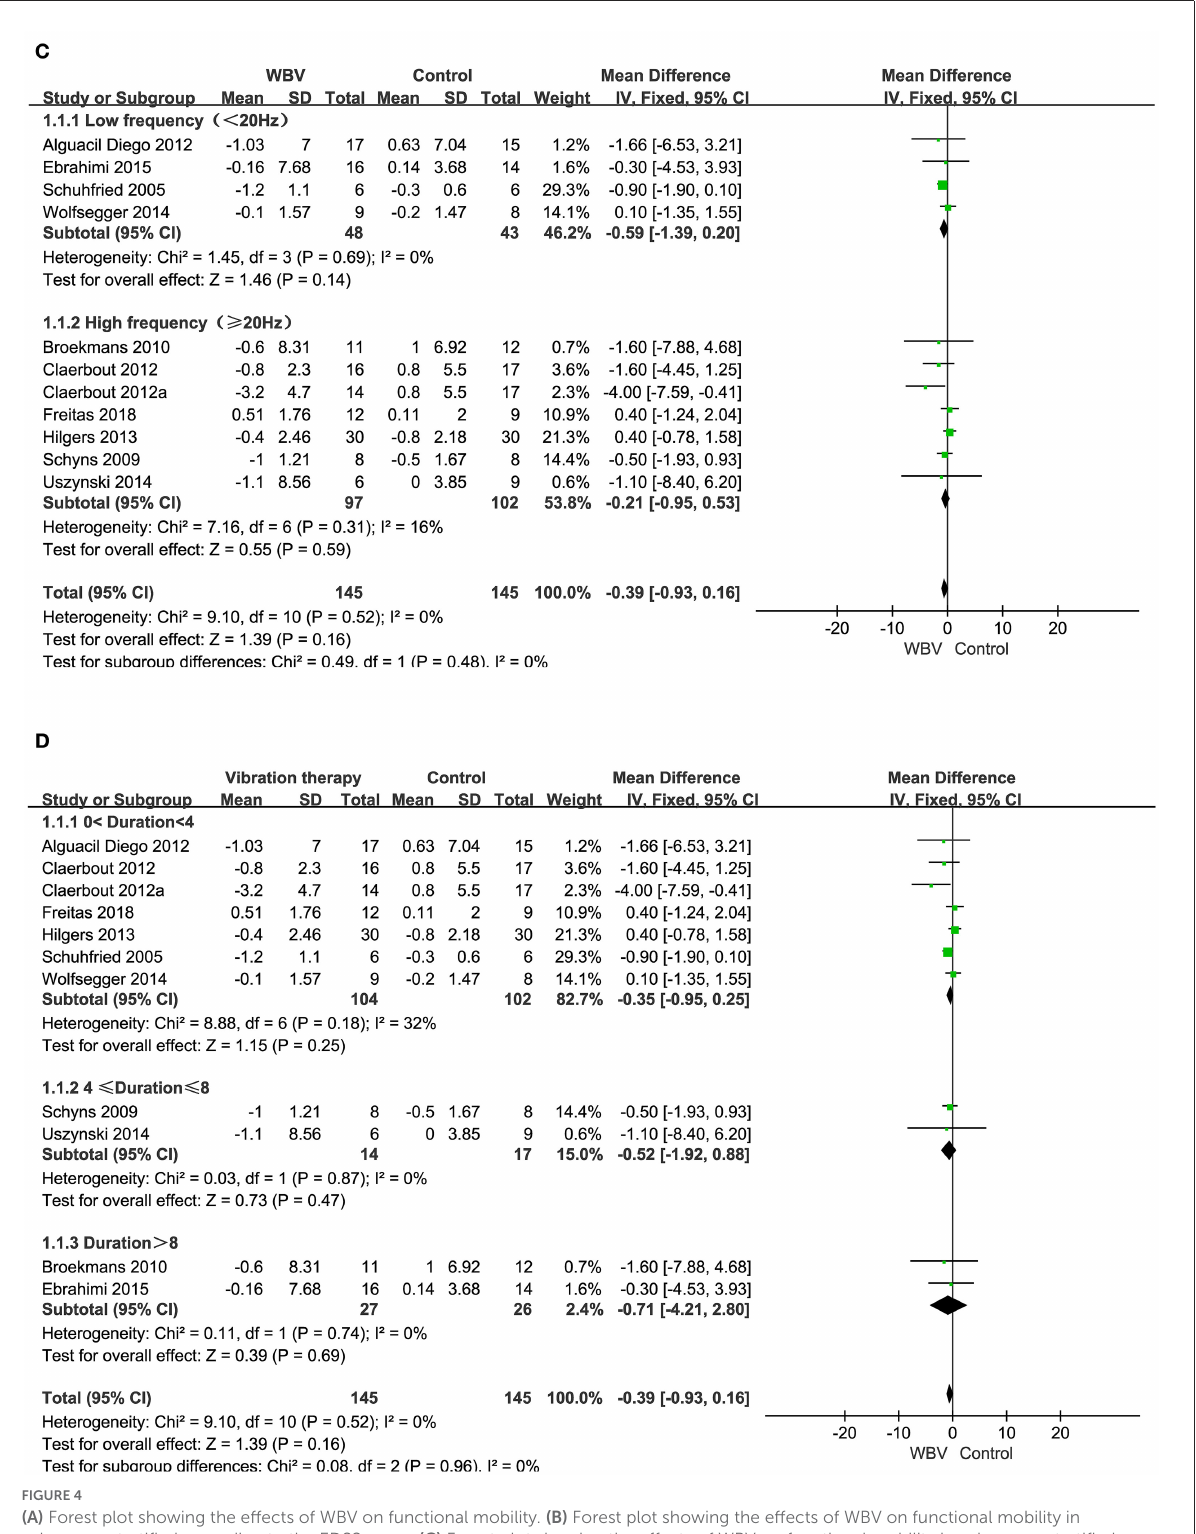
FIGURE4 (A) Forest plot showing the effects of WBV on functional mobility. (B) Forest plot showing the effects of WBV on functional mobility in subgroups stratified according to the EDSS score. (C) Forest plot showing the effects of WBV on functional mobility in subgroups stratified according to the frequency. (D) Forest plot showing the effects of WBV on functional mobility in subgroups stratified according to the different durations of the